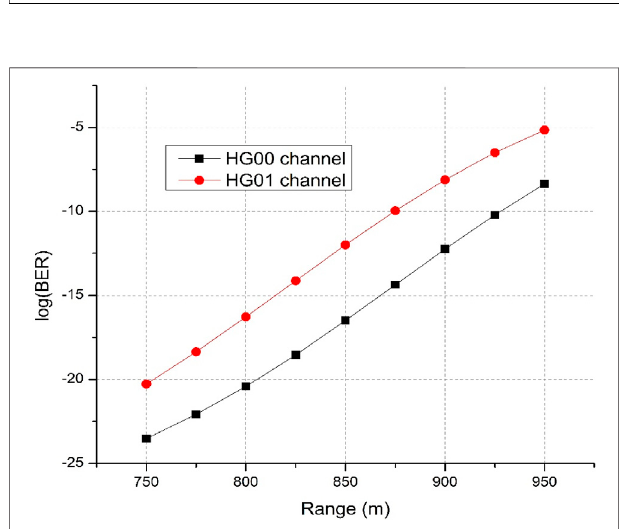
FIGURE 7 | log (BER) v/s transmission distance for light dust.